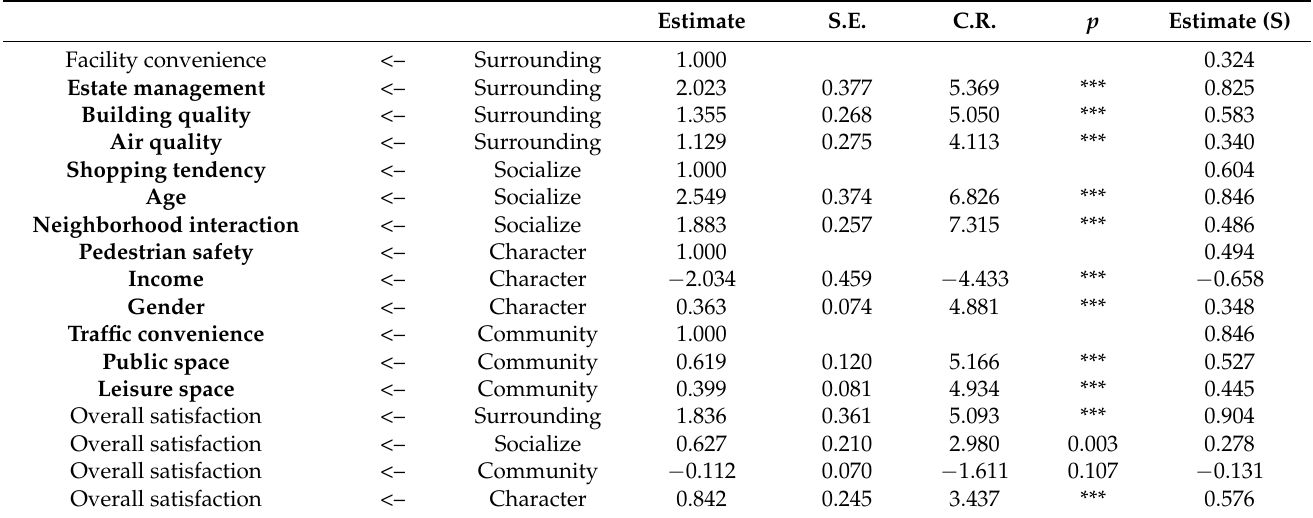
Table 8. Modified SEM coefficient results for Nanhuan.